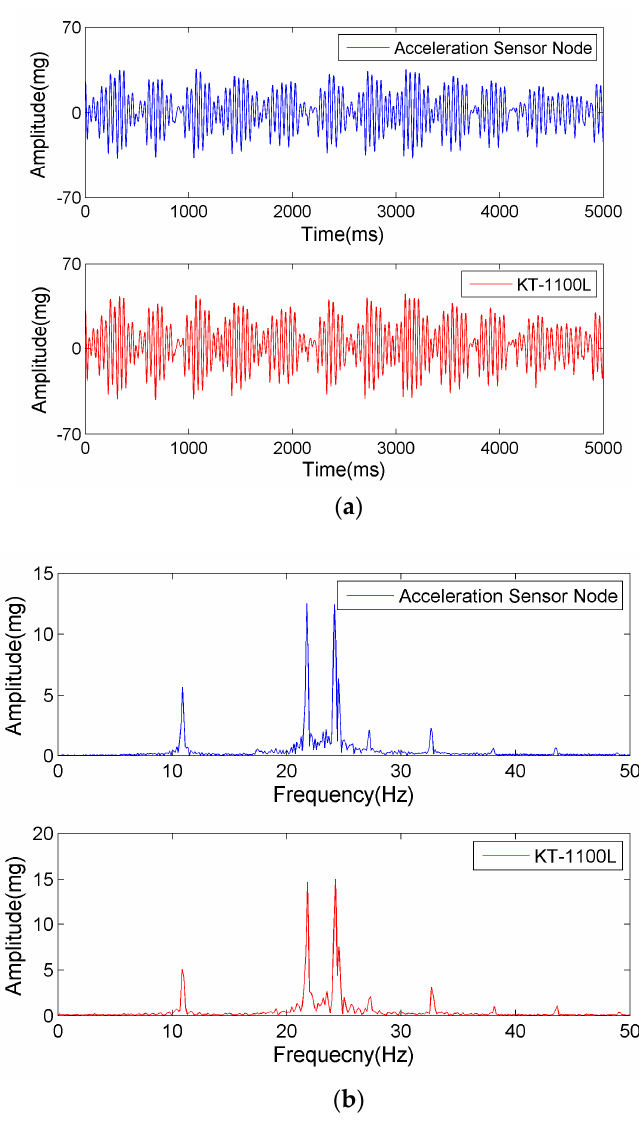
Figure 8. The measured acceleration signals on the shaking table. ( a ) Time domain signal; ( b ) Frequency domain signal.